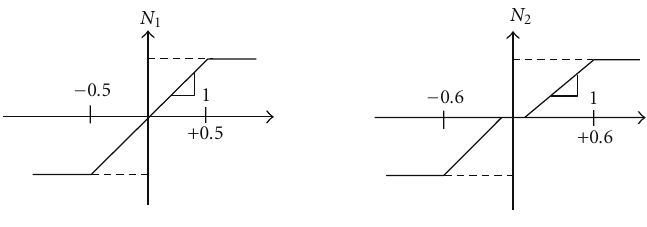
Figure 9: Nonlinearities of Example 1.